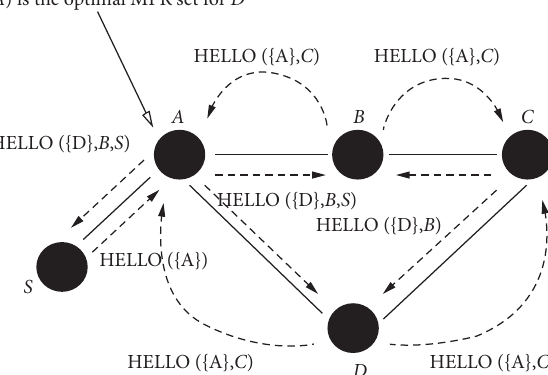
Figure 3: The working principle of the OLSR [8, 9, 12–14].